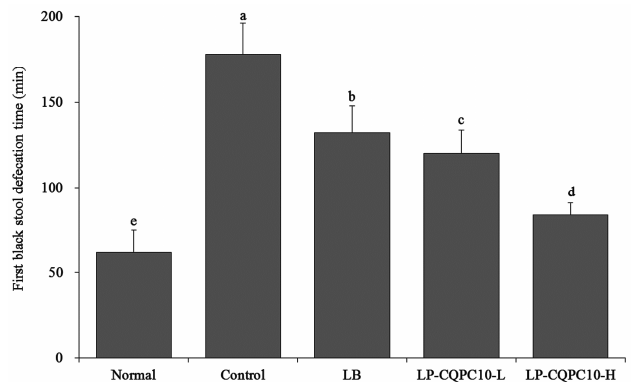
Figure 2. First black stool defecation time of the mice. Values presented are the mean ± standard deviation. a–e Mean values with different letters in the same bars are significantly different ( p < 0.05) according to Duncan’s multiple-range test. LB: Lactobacillus bulgaricus (1.0 × 10 9 colony-forming unit (CFU)/kg body weight (bw)); LP-CQPC10-L: Lactobacillus plantarum CQPC10 (1.0 × 10 8 colony-forming unit (CFU)/kg body weight (bw)); LP-CQPC10-H: Lactobacillus plantarum CQPC10 (1.0 × 10